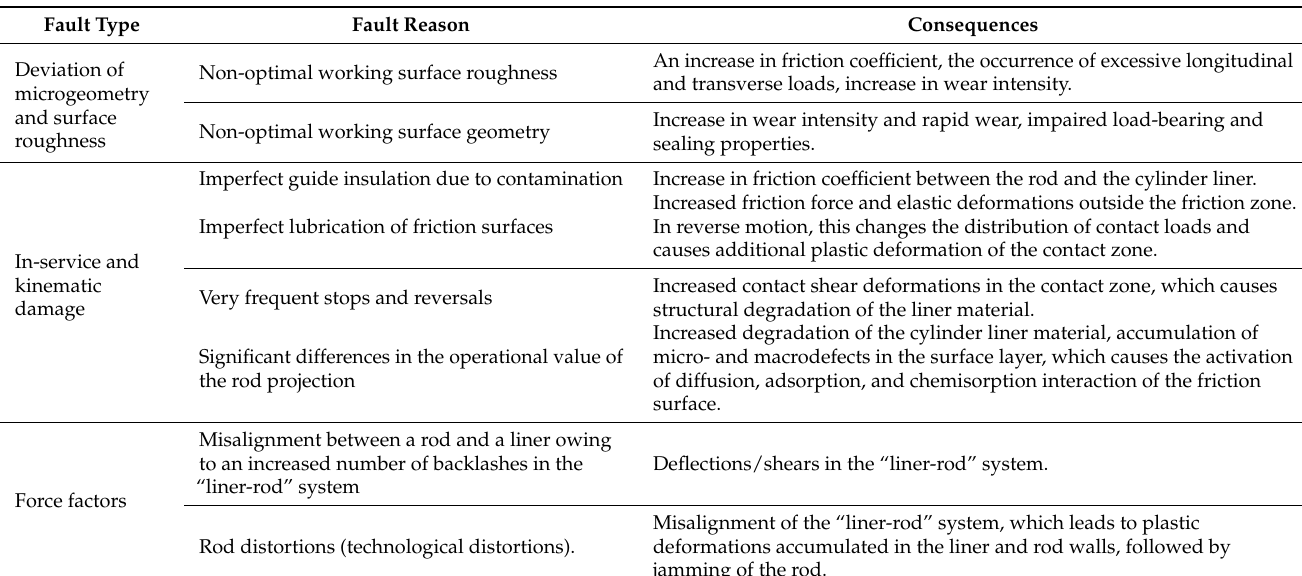
Table 1. Types of hydrocylinder failures caused by suboptimal microgeometry, surface roughness, kinematic, and force factors. Fault